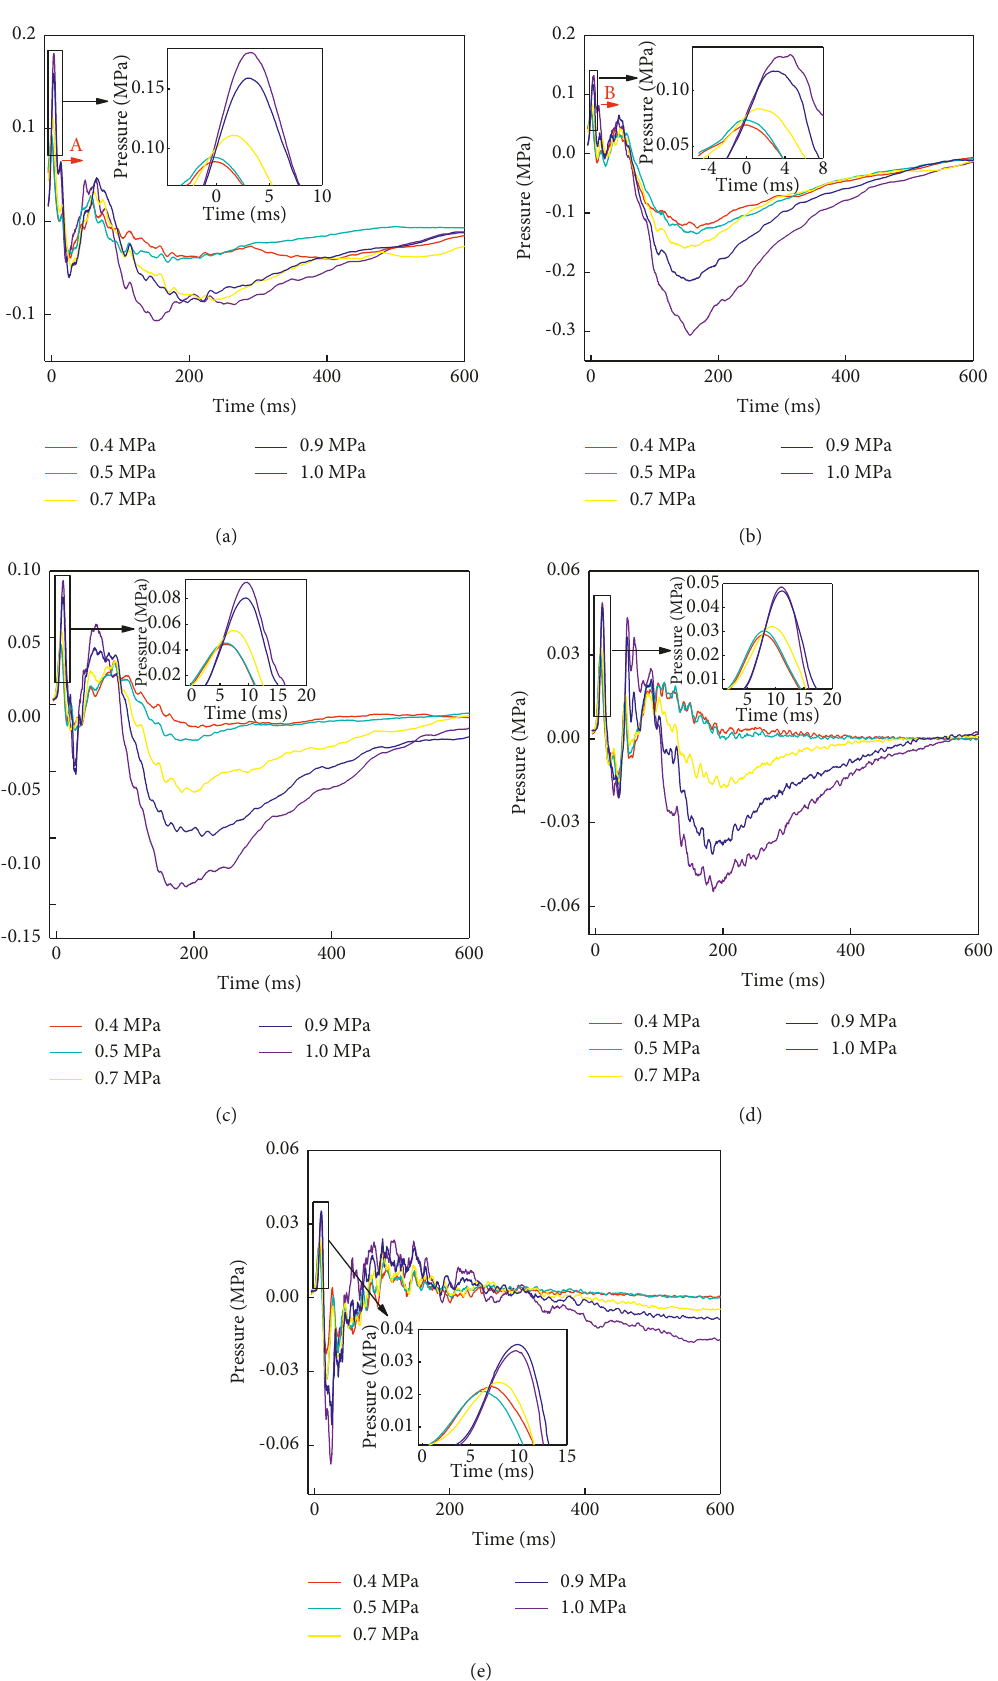
Figure 5: Shock wave overpressure change curve (a) Point No. 1. (b) Point No. 2. (c) Point No. 3. (d) Point No. 4. (e) Point No.